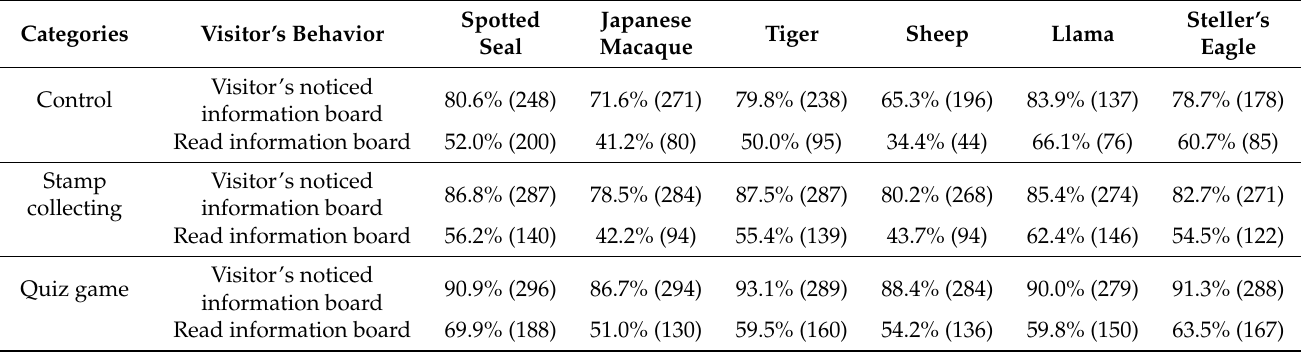
Table 3. Perception to information board and behavior of